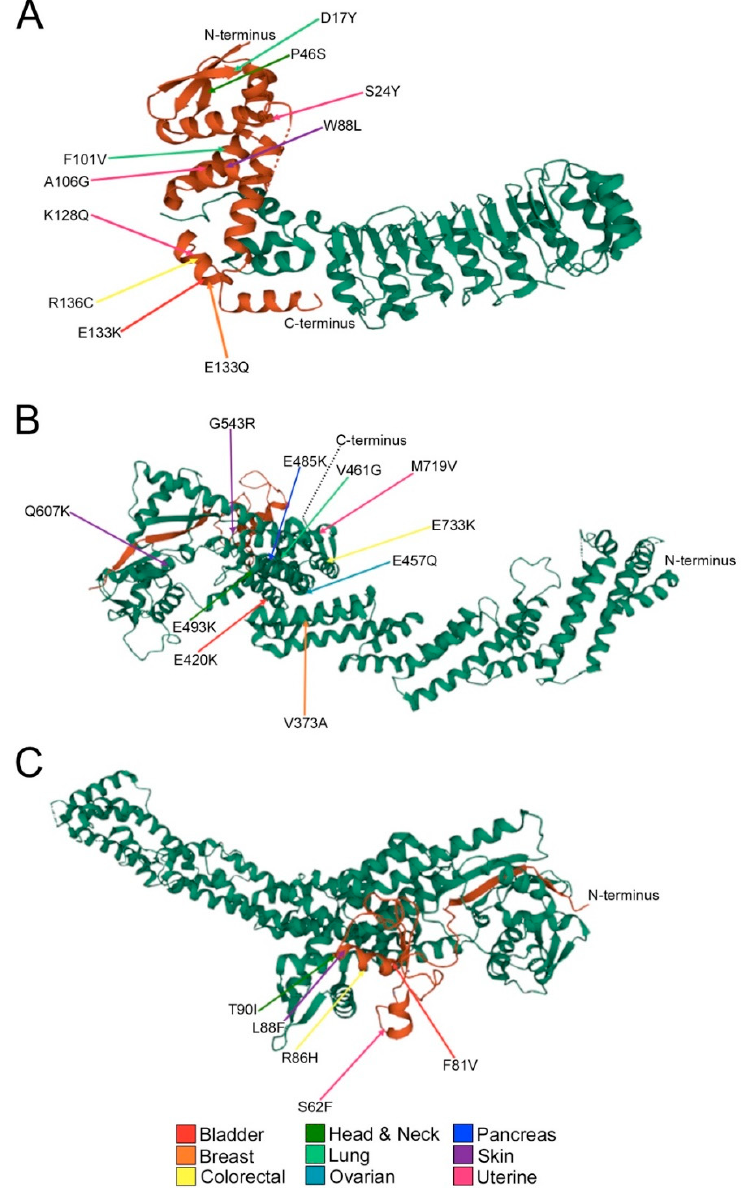
Figure 3. Missense mutations underlie potentially damaging alterations in core SCF complex members. ( A ) Partial crystal structure (missing amino acids 1-14; ribbon model) of the SKP1 (brown)-SKP2 (green) complex shows predicted detrimental alterations. Indicated amino acid substitutions are deemed deleterious, possibly damaging or probably damaging by SIFT and PolyPhen-2 databases (Table S2) and are predicted to impact protein–protein interactions between SKP1 and CUL1 or SKP1 and SKP2. Amino acids are denoted by their single letter code, numbers indicate amino acid position in the SKP1 protein. Colored arrows identify cancer type in which the underlying mutation was identified (see key). ( B ) Partial crystal structure (missing amino acids 1-16; ribbon model) of the CUL1 (green)-RBX1 (brown) complex presents predicted detrimental alterations. Indicated alterations are deemed deleterious, possibly/probably damaging by SIFT and PolyPhen-2 and are predicted to impact protein–protein interactions between CUL1-RBX1 or CUL1-SKP1. ( C ) Partial crystal structure (missing amino acids 1-18; ribbon model) of the CUL1 (green)-RBX1 (brown) complex presents predicted detrimental alterations. Indicated alterations are deemed deleterious, possibly/probably deleterious by SIFT and PolyPhen-2 and are predicted to impact protein–protein interactions between RBX1-CUL1 or RBX1-E2 conjugase.